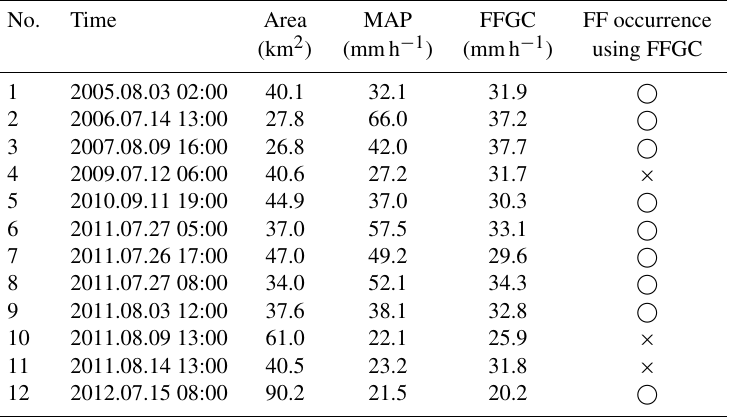
Table 4. Validation of flash flood guidance criteria (FFGC) using observed flash flood (FF) cases. The (cid:13) and × indicate yes and no, respectively. No. Time Area